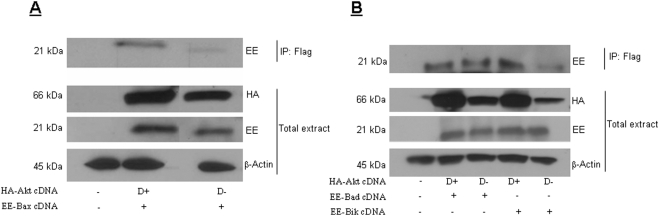
(A) Akt activity regulates Bcl-w interaction with Bcl-2 family members.Flag-Bcl-w/HeLa cells were transfected with 2 µg of either HA-Akt D+ or HA-Akt D− cDNA, and 2 µg of EE-Bax cDNA for 48 hr. Cells were harvested and 1 mg of total lysate immunoprecipitated using an anti-Flag antibody. The immunoprecipitates were then blotted with an anti-EE antibody. Total protein was normalized using anti-EE, -HA or -β-actin antibodies, as indicated. (B) Flag Bcl-w/HeLa cells were transfected with 2 µg of HA-Akt D+ or HA-Akt D− cDNA, and 2 µg of either EE-Bad or EE-Bik cDNA, as indicated, for 48 hr. Cells were harvested and 1 mg of total lysate immunoprecipitated using anti-Flag antibody. The immunoprecipitates were then blotted with an anti-EE antibody. Total protein was normalized using anti-EE, -HA or -β-actin antibodies, as indicated. Inactivation of Akt induced a reduction of Bcl-w interaction with the pro-apoptotic Bcl-2 members.